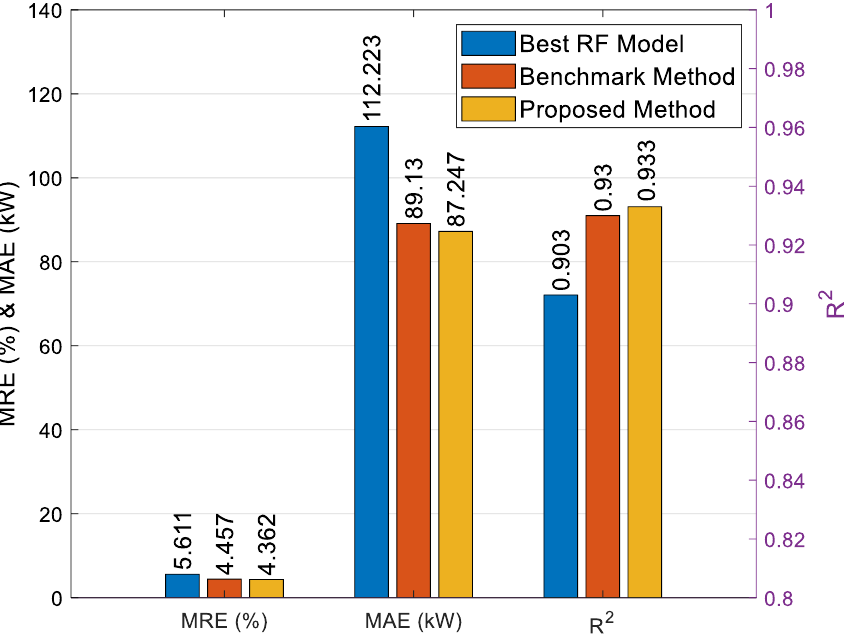
Figure 15. MRE, MAE, R 2 barplot for the best RF, stacking RNN and proposed